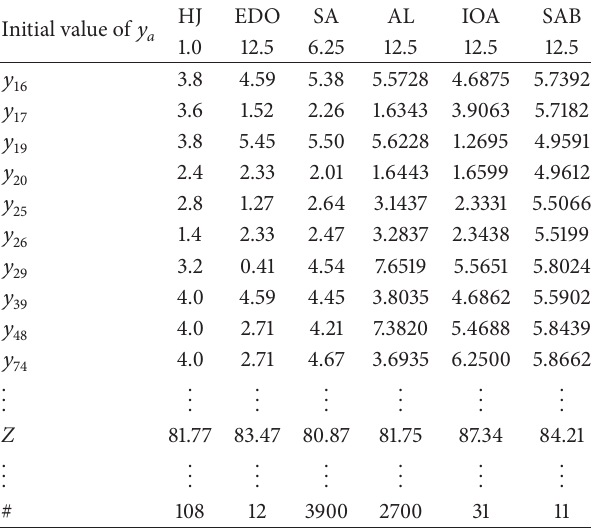
Table 8: Comparison of results from solving the Sioux Falls network.